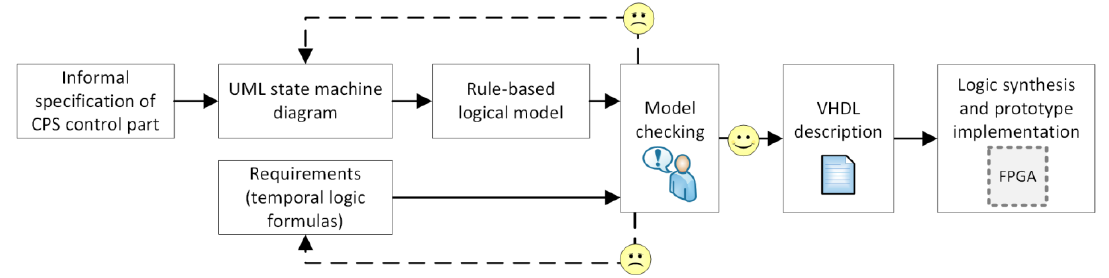
Figure 1. UML state machine diagrams and their verification in the CPS design: schema of the proposed approach.